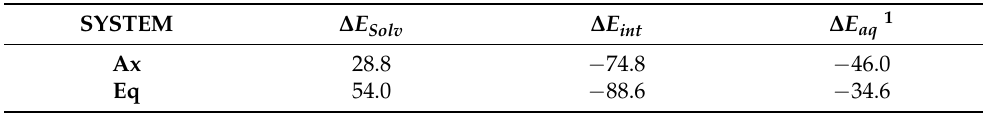
Table 3. Contributions of the solvation energies ( ∆ E Solv ) for the most stable modes of interaction